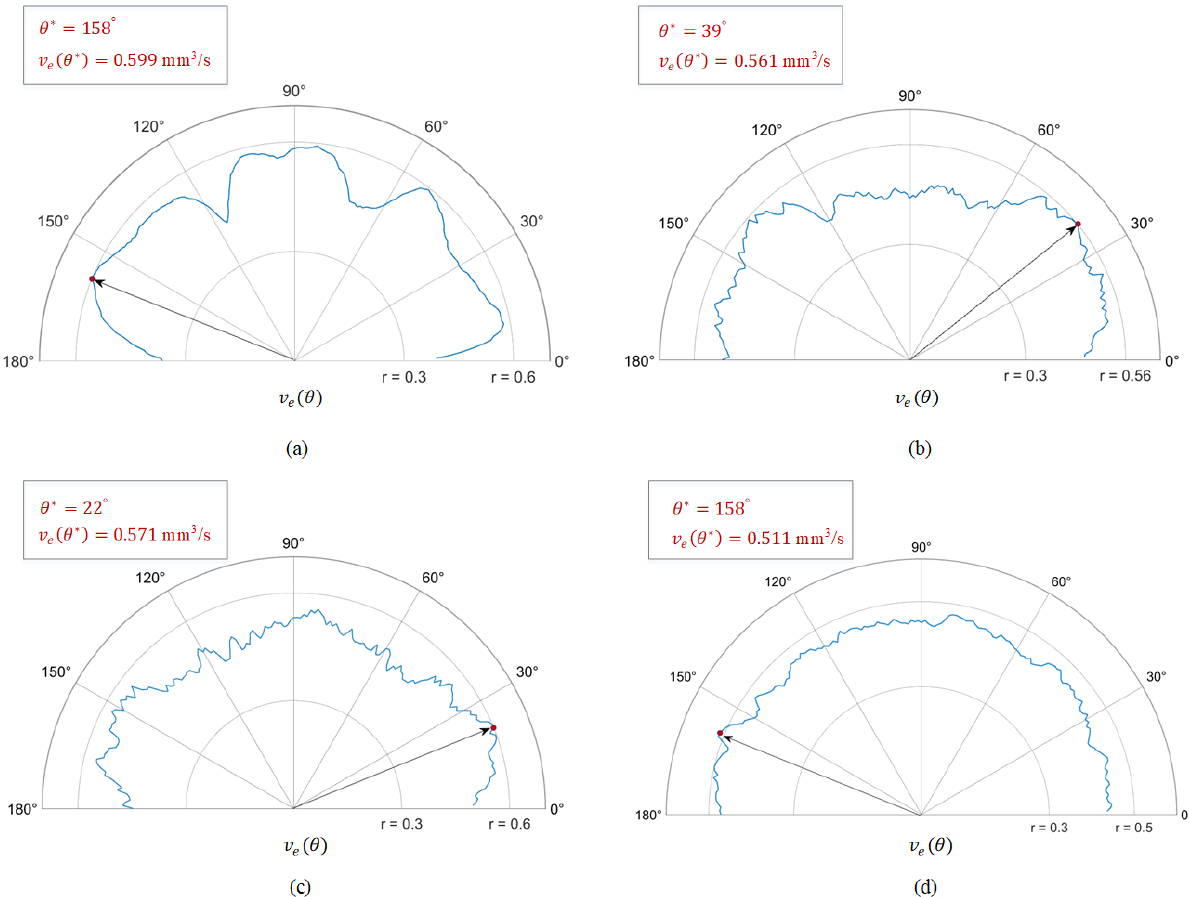
Figure 9. Material deposition rate 𝑣 𝑒 (𝜃) for: ( a ) Saddle surface 𝑆 1 , ( b ) Bicycle surface 𝑆 2 , ( c ) Freeform surface 1 𝑆 3 , and ( d ) Freeform surface 2 𝑆 4 , among 𝜃 ∈ [0,𝜋] and the found maximum 𝜃 ∗ .